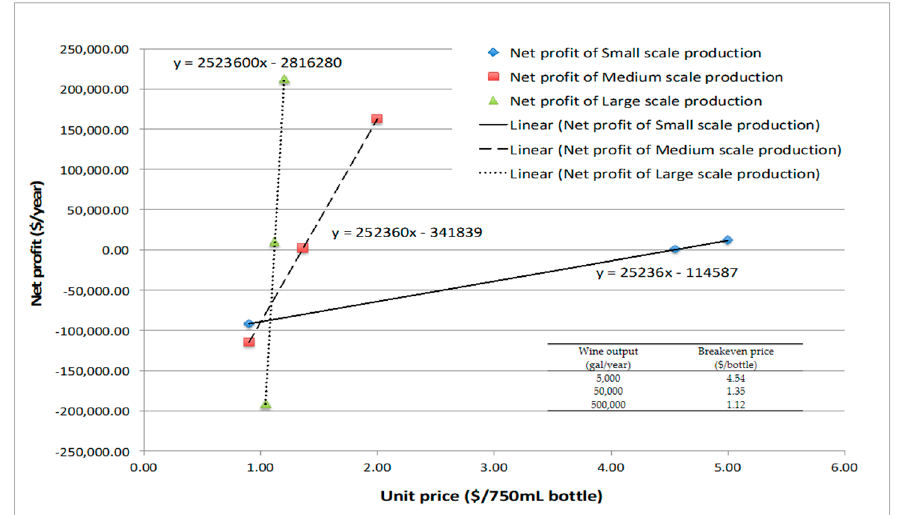
Figure 13. Estimated net profit and break-even price (where each profit trend line crosses the x -axis) according to scale of operation. Note that the larger the production scale is, the faster the break-even price is achieved.